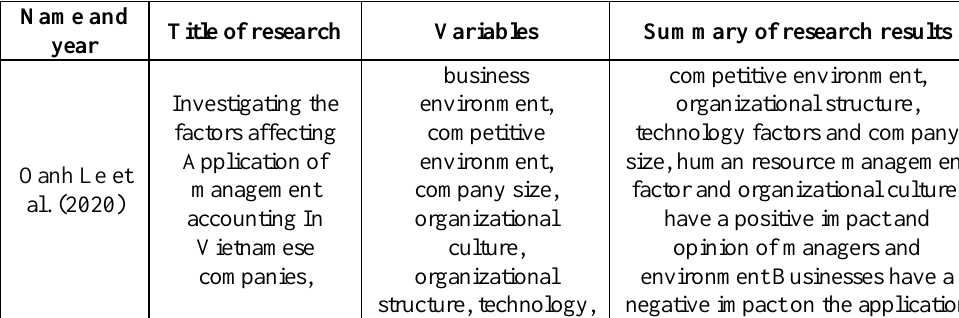
Table 2. Summary of research